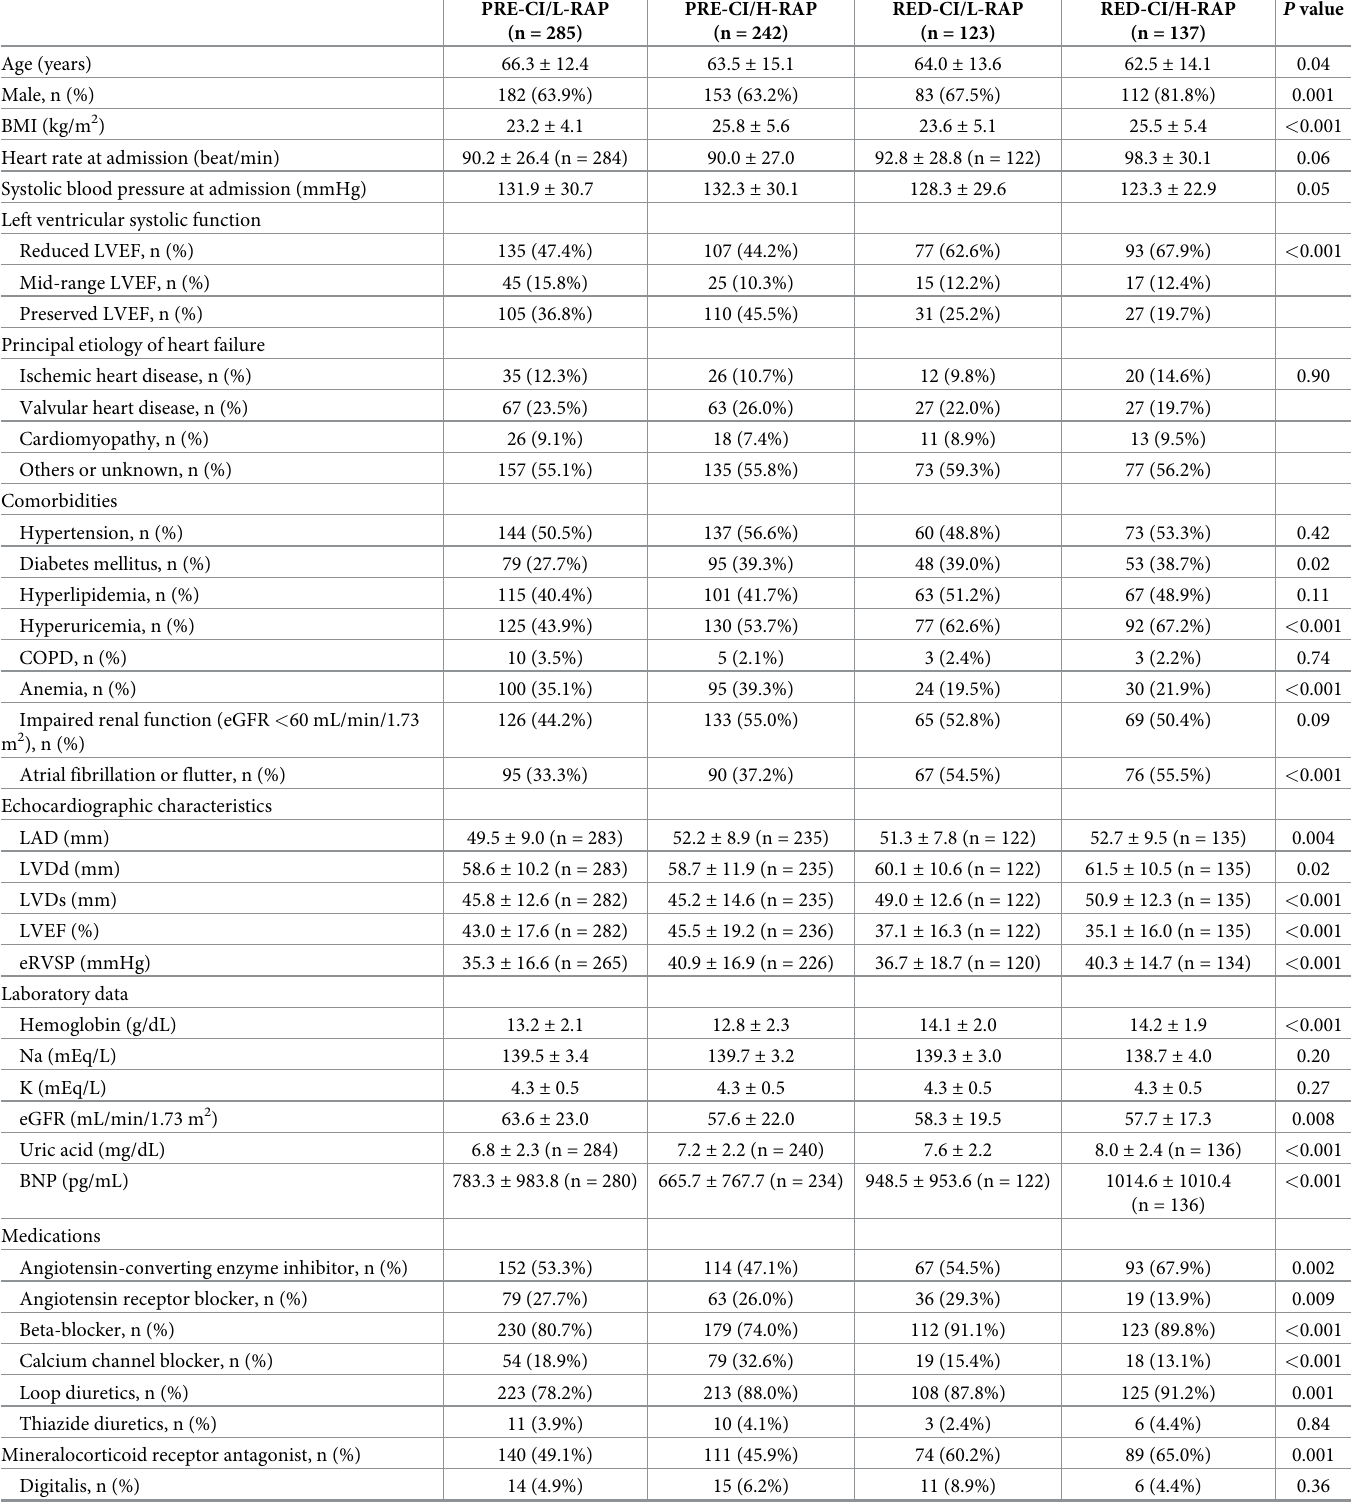
Table 1. Clinical